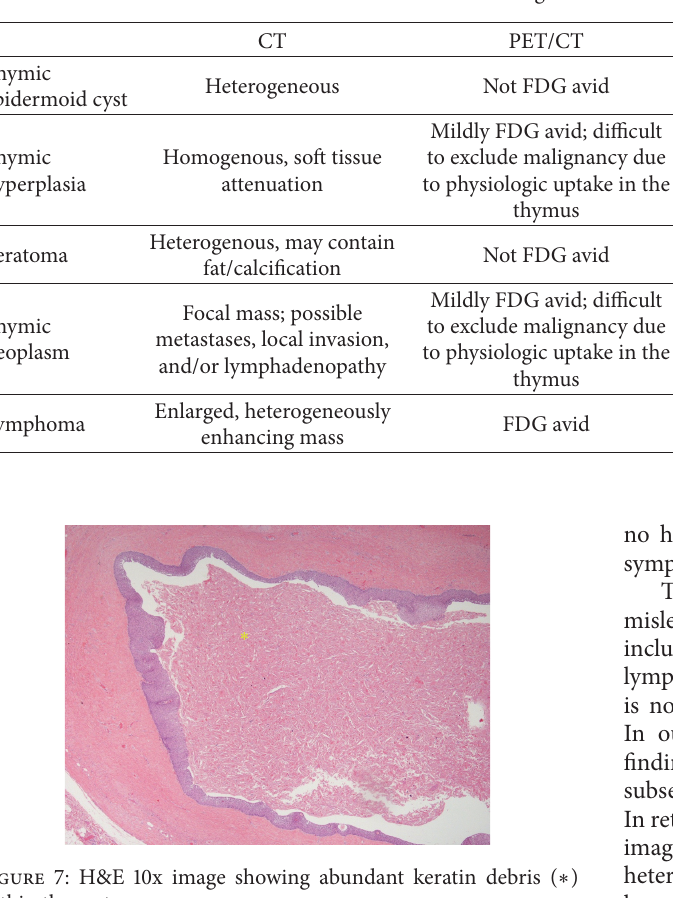
Table 1: Differential diagnosis of an anterior mediastinal mass.